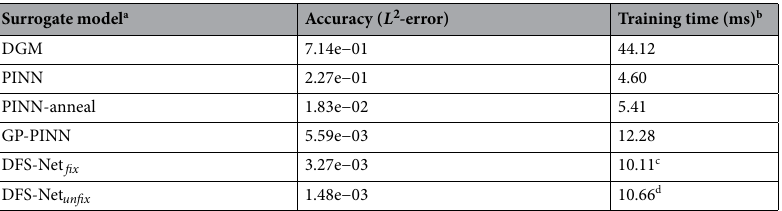
Table 1. Comparison of the relative L 2 -error of different neural network-based surrogate models on the Helmholtz equation ( α 1 = 1, α 2 = 4 ). a All models consists of three hidden layers with 50 neurons in each layer. b The training time for each Adam epoch. c The training time of DFS-Net fix for each L-BFGS-B epoch is 22.01 ms. d The training time of DFS-Net unfix for each L-BFGS-B epoch is 23.88 ms.